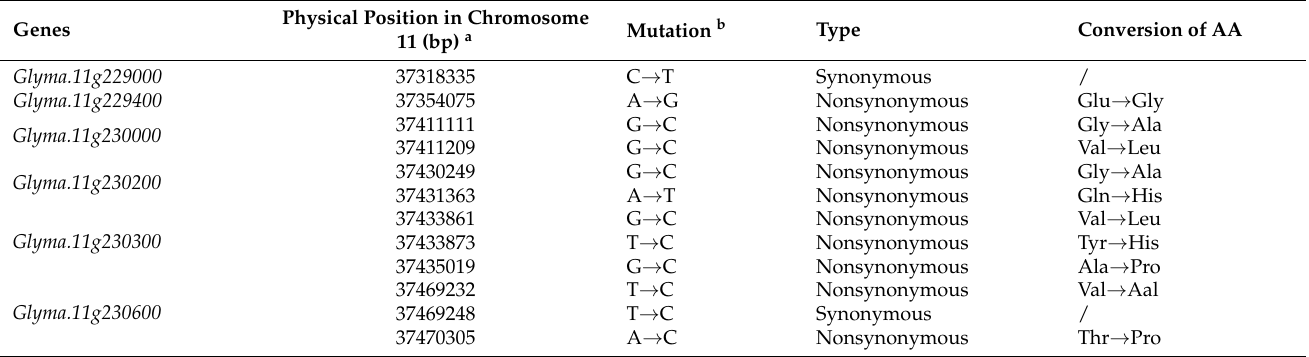
Table 4. The SNPs in the spwp2 locus on chromosome 11 in the spwp